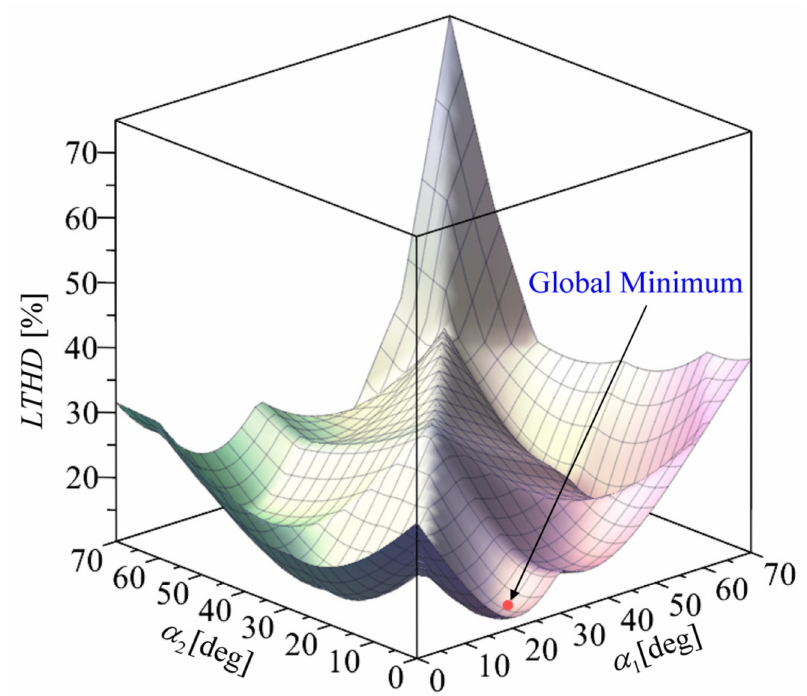
Figure 4. Analytical LTHD with global minimum for N =